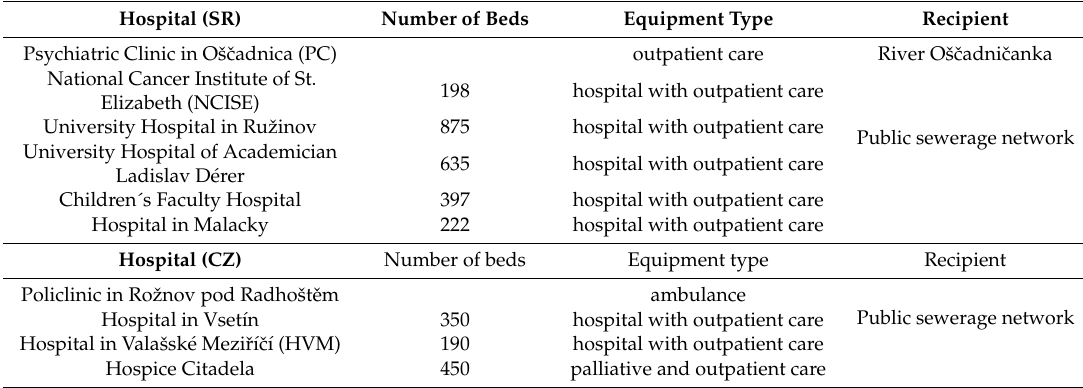
Table 1. Characteristics of healthcare